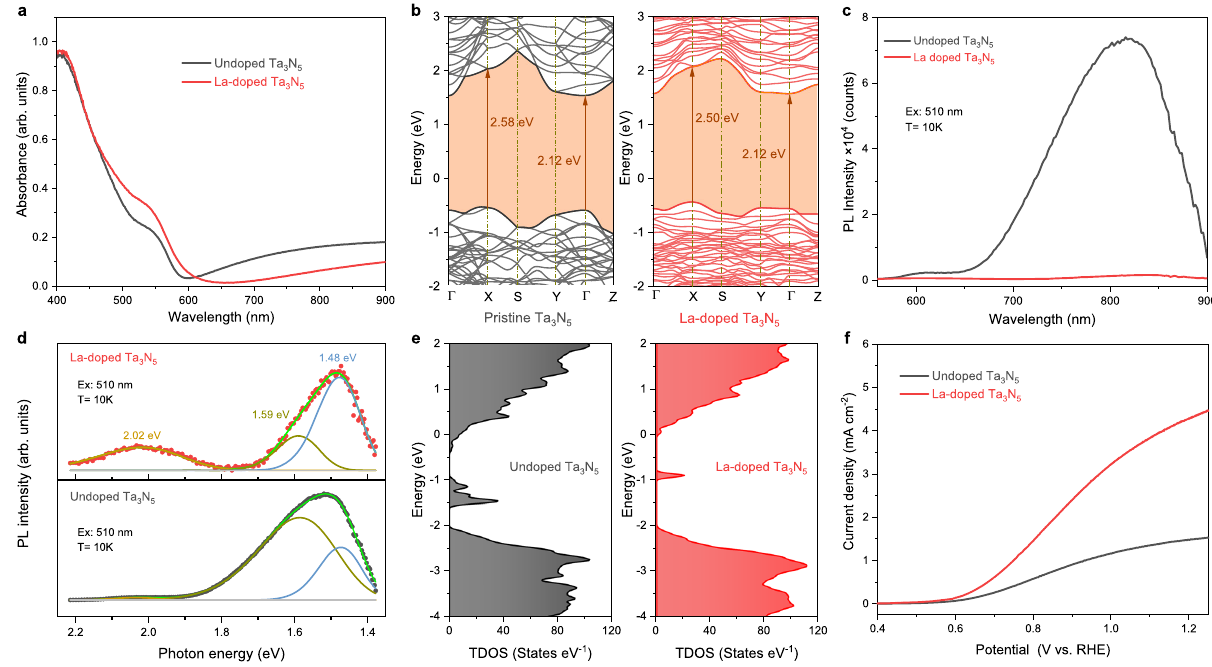
Fig. 1 | Effect of La doping on the optical and PEC properties of Ta 3 N 5 . a UV-vis absorption spectra of undoped Ta 3 N 5 and La-doped Ta 3 N 5 thin fi lms on quartz sub- strates. b The calculated electron energy bands using MBJ exchange potential for pristine Ta 3 N 5 and La-doped Ta 3 N 5 . The brown arrows mark the optical transition gaps. c Low-temperature PL spectra of undoped Ta 3 N 5 and La-doped Ta 3 N 5 thin fi lms